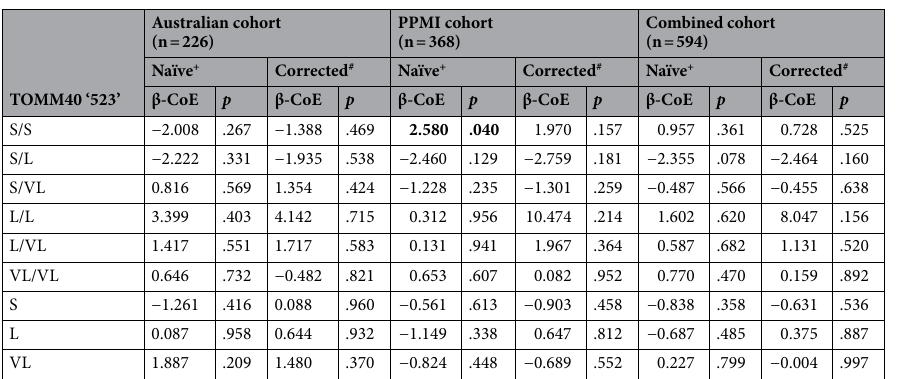
Table 3. Generalised linear model investigating association between TOMM40 ‘523’ and age of PD symptom onset in the Australian and PPMI cohorts. + Data taken from GLM without correction for covariates. # Data taken from GLMs corrected for APOE ε4 load and patient sex. P and β-CoE values are calculated for the comparison to all other genotypes or alleles. PPMI, Parkinson’s Progression Markers Initiative; PD, Parkinson’s disease; β-CoE , β-Coefficient ; p , statistical significance ( p value); S/S, short/short; S/L, short/long; S/VL, short/ very long; L/L, long/long; L/VL, long/very long; VL/VL, very long/very long; S, short; L, long; VL, very long; GLM, generalised linear